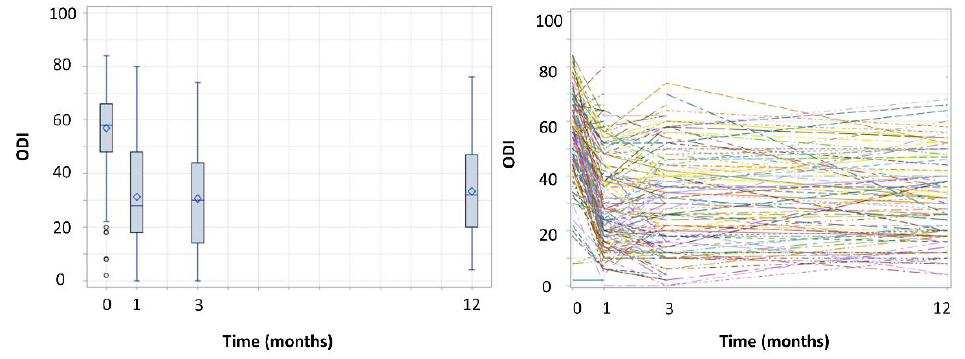
Figure 1. Distribution of total score on the Oswestry Disability Index (ODI) per study visit, presented with boxplots ( left ) and individual profile plots ( right ). The mean is represented by the diamond, the horizontal line represents the median ODI score at each visit.